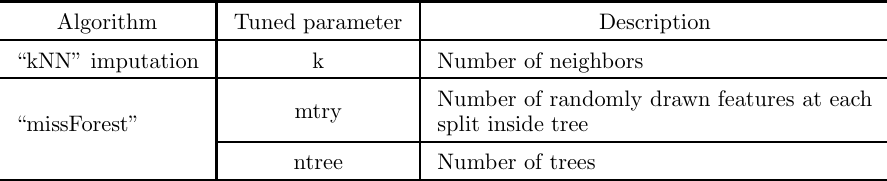
Table 1. Tuned parameters – imputation algorithms